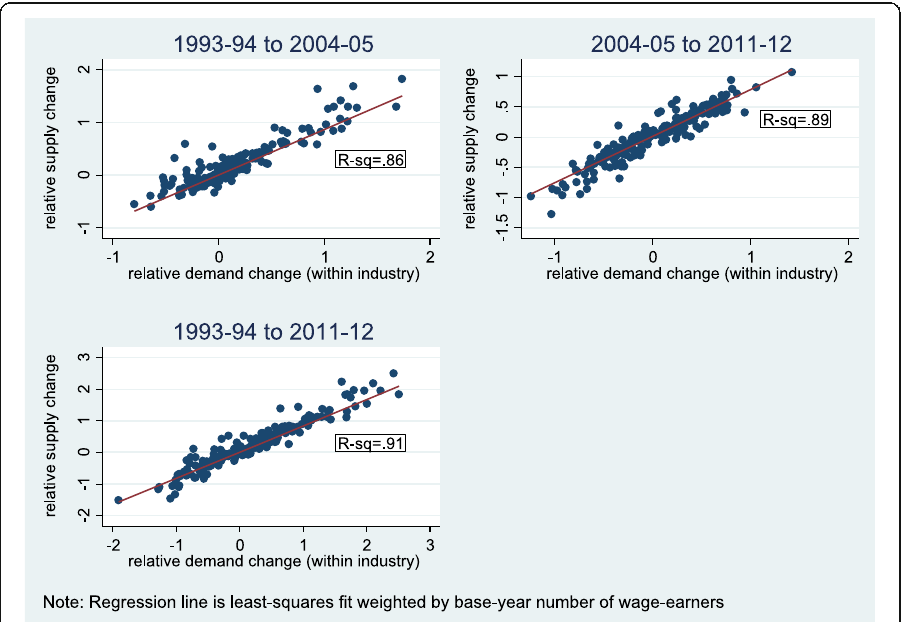
Fig. 18 Bivariate relationship between state/group supply and within-industry demand